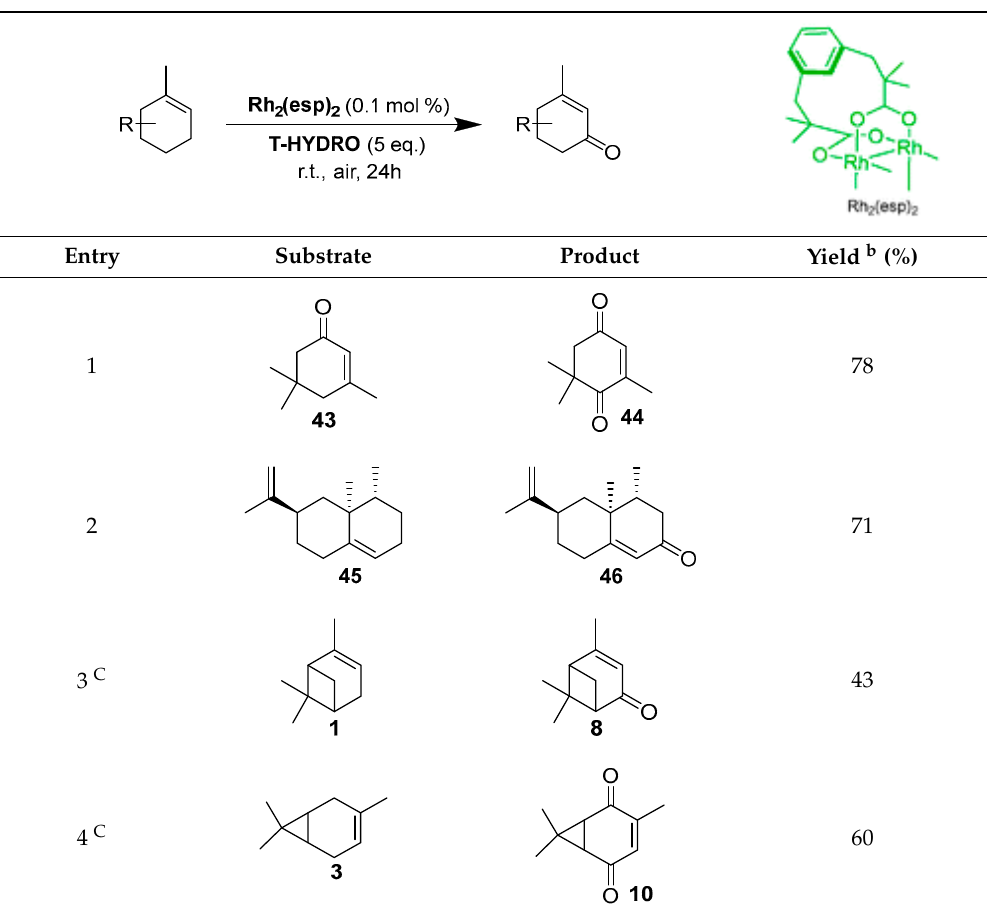
Table 15. Allylic oxidation of olefins by Rh 2 (esp) 2 /T-HYDRO under optimized reaction conditions a (adapted from reference [57]).